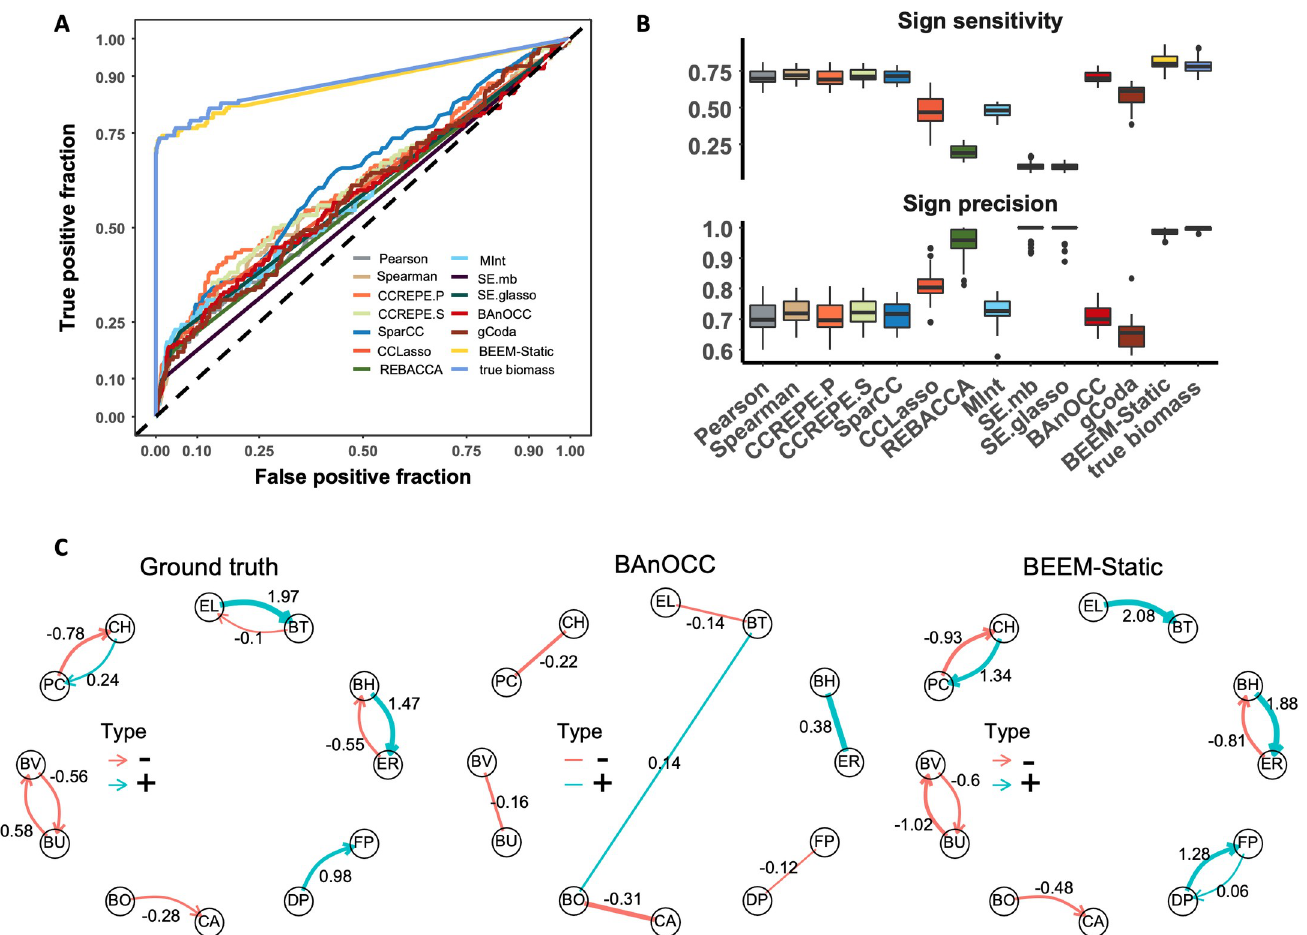
Fig 2. Benchmarking performance for network structure and edge directionality. Note that CCREPE has two versions with Pearson and Spearman correlations (CCREPE.P and CCREPE.S), while SPIEC-EASI using “mb” and “glasso” algorithms is represented as SE.mb and SE.glasso, respectively. (A) ROC curves for different correlation based methods, the regression method using true biomass values and BEEM-Static for one simulated dataset with 30 species and 500 samples. (B) Boxplots showing precision and recall for directionality/sign of interactions for 30 different simulated communities with 30 species and 500 samples each. (C) True interaction network for a synthetic community based on all-pair co-culture data (Ground truth), inferred correlation network by BAnOCC and inferred interaction network by BEEM-Static (numbers on edges represent gLVM parameter values or correlation coefficients). PC: Prevotella copri , BV: Bacteroides vulgatus , BU: Bacteroides uniformis , BO: Bacteroides ovatus , BT: Bacteroides thetaiotaomicron , FP: Faecalibacterium prausnitzii , BH: Blautia hydrogenotrophica , ER: Eubacterium rectale , CA: Collinsella aerofaciens , EL: Eggerthella lenta , DP: Desulfovibrio piger , CH: Clostridium hiranonis .